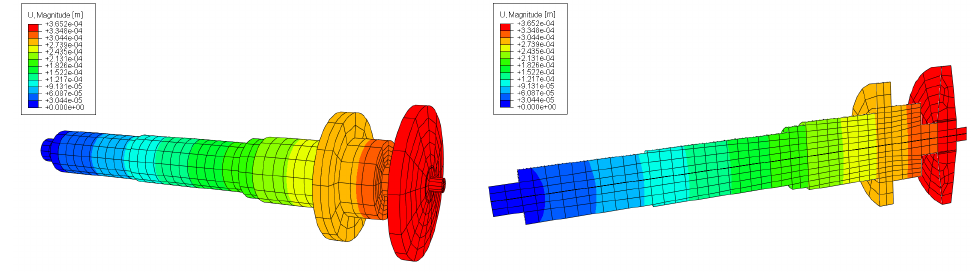
Figure 4: The distribution of rotor displacements caused by heating during operation.